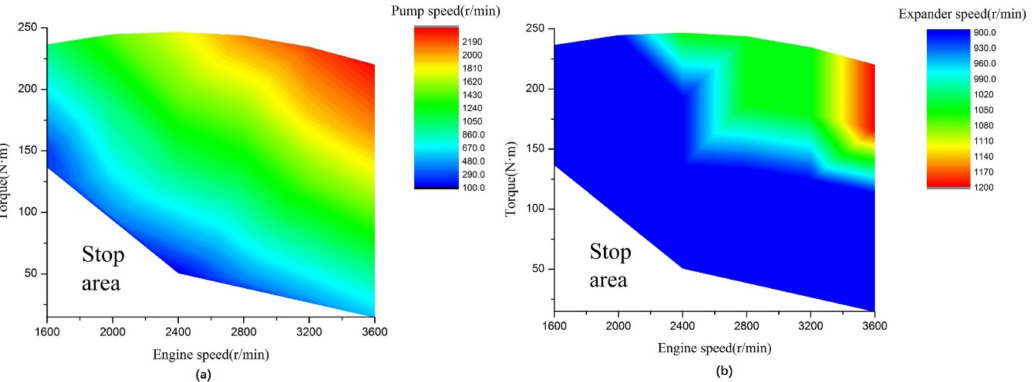
Figure 10. Results for the optimal operation point of the ORC under various engine operation conditions: ( a ) The pump speed and ( b ) the expander